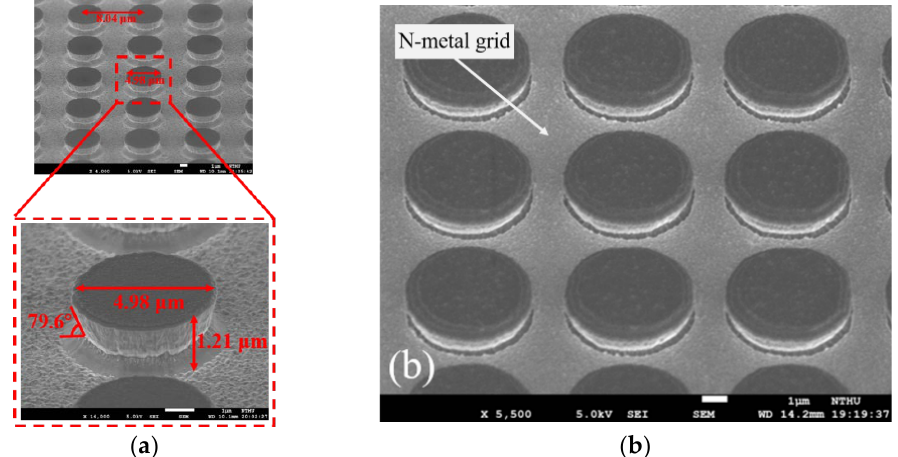
Figure 2. ( a ) The MicroLED array with the upside-down trapezoid mesa observed at 45˚ viewing angle via scanning electron microscope (SEM). The mesa diameter is 4.98 μm, the mesa height is 1.2 μm, and the sidewall tilts at an angle of 80 degrees. We can see the corner of the sidewall just like the projection of the mesa. ( b ) The SEM image of MicroLEDs with n-metal grid.